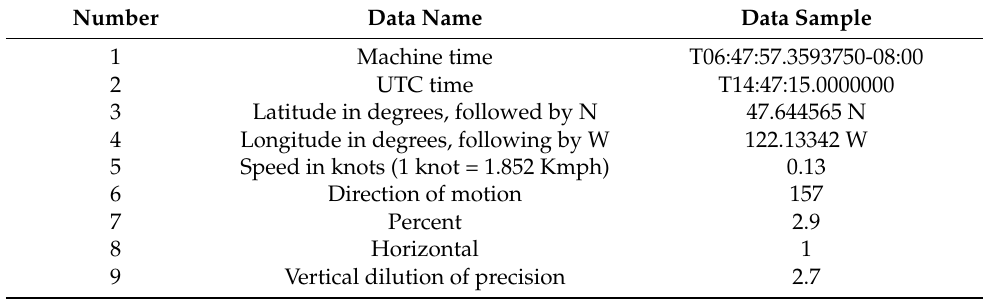
Table 2. GPS data fields.